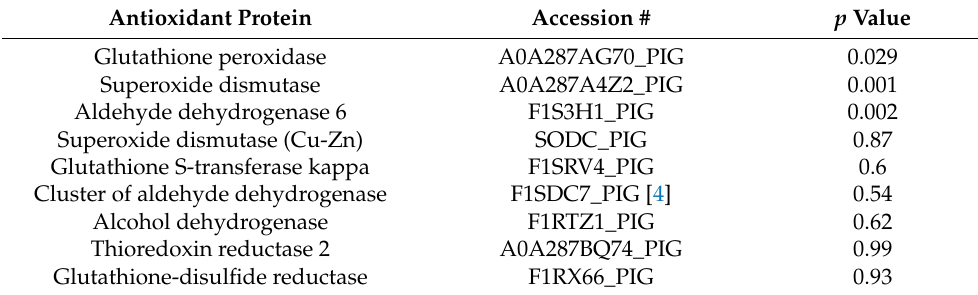
Figure 3. The figure demonstrates a potential mechanism for the addition of CoQ 10 in the diet for 4 weeks and how enhanced electron transport chain functioning through complex III (Q-cycle) reduces the generation of reactive oxygen species in the intermembrane space [128]. Table 1. Mitochondrial anti-oxidant